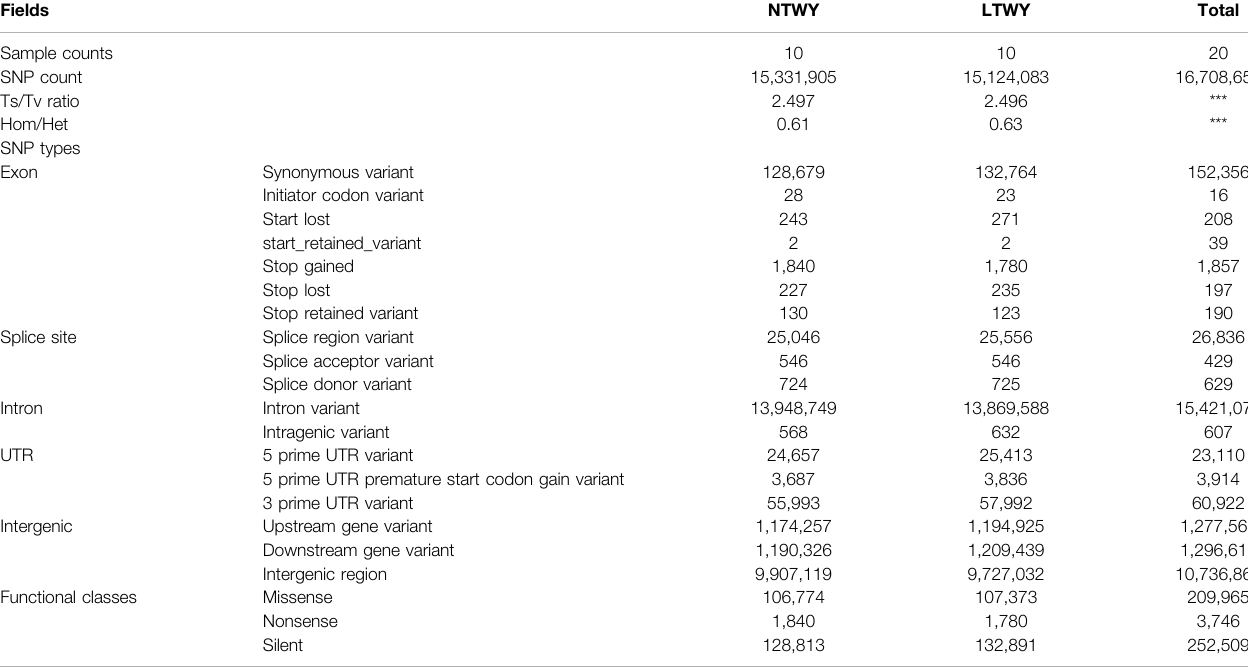
TABLE 2 | Functional annotation of the identi fi ed single-nucleotide polymorphisms (SNPs) in NTWY and